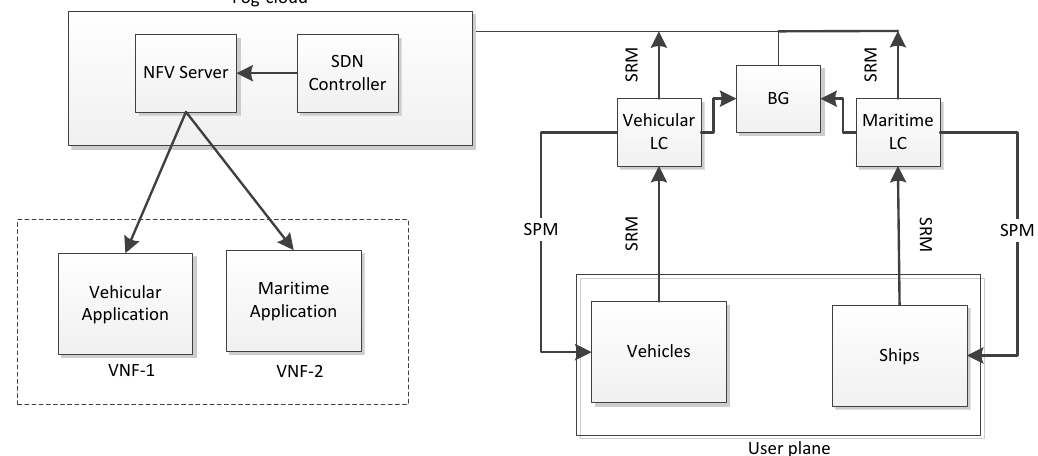
Figure 3. A flowchart representing the proposed